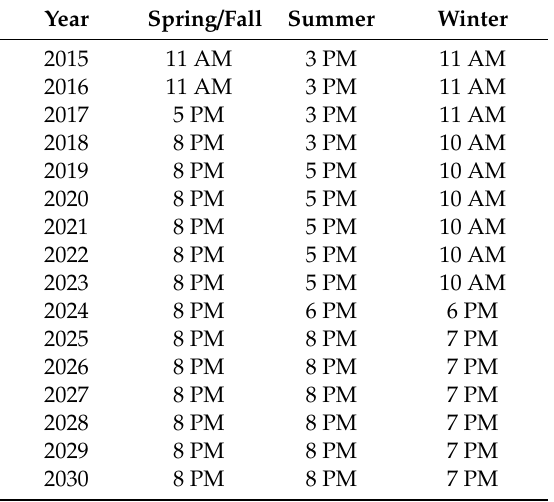
Table 11. Peak load time by season from 2015 to 2030 considering only PV